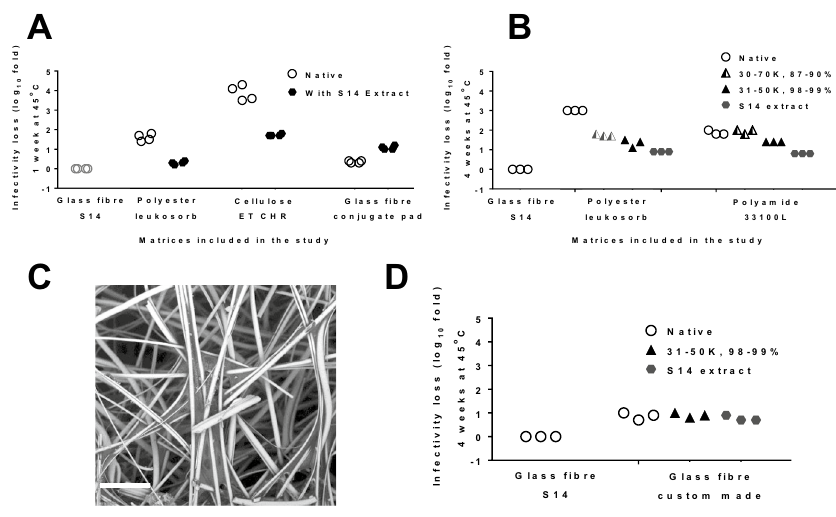
Figure 6. PVA improves vaccine thermostability on matrices. A PVA-containing extract prepared from S14 was dried onto various fresh matrices, followed by drying of vaccine in 0.5 M (50:50) trehalose-sucrose onto the treated matrices and untreated comparator matrices. Viable virus recovery was assessed after thermochallenge as indicated for each panel. S14 was included as a comparator in each experiment. Panel ( A ) shows loss in infectivity titre of vaccine in the absence (open circles) or presence (solid circles) of PVA extracted from glass fibre (S14), as compared to − 80 °C stored liquid control, after 1 week at 45 °C. Points indicate individual samples (four replicates per condition). Panel ( B ) shows difference in loss in infectivity titre of vaccine loaded in polyester (leukosorb) and polyamide (33100L) matrix modified by deposition of three different types of PVA prior to application and drying of vaccine. Dried samples were subjected to thermochallenge for 4 weeks at 45 °C. Points indicate individual samples (three replicates per condition). Panel ( C ) shows a scanning electron microscope image of the custom-made glass fibre matrix. Scale bar shows 50 µm. Panel ( D ) compares loss in infectivity titre of vaccine post-thermochallenge between standard 14 and custom-made glass fibre matrix modified by deposition of two different types of PVA prior to application and drying of vaccine. Dried samples were subjected to thermochallenge for 4 weeks at 45 °C. Points indicate individual samples (three replicates per